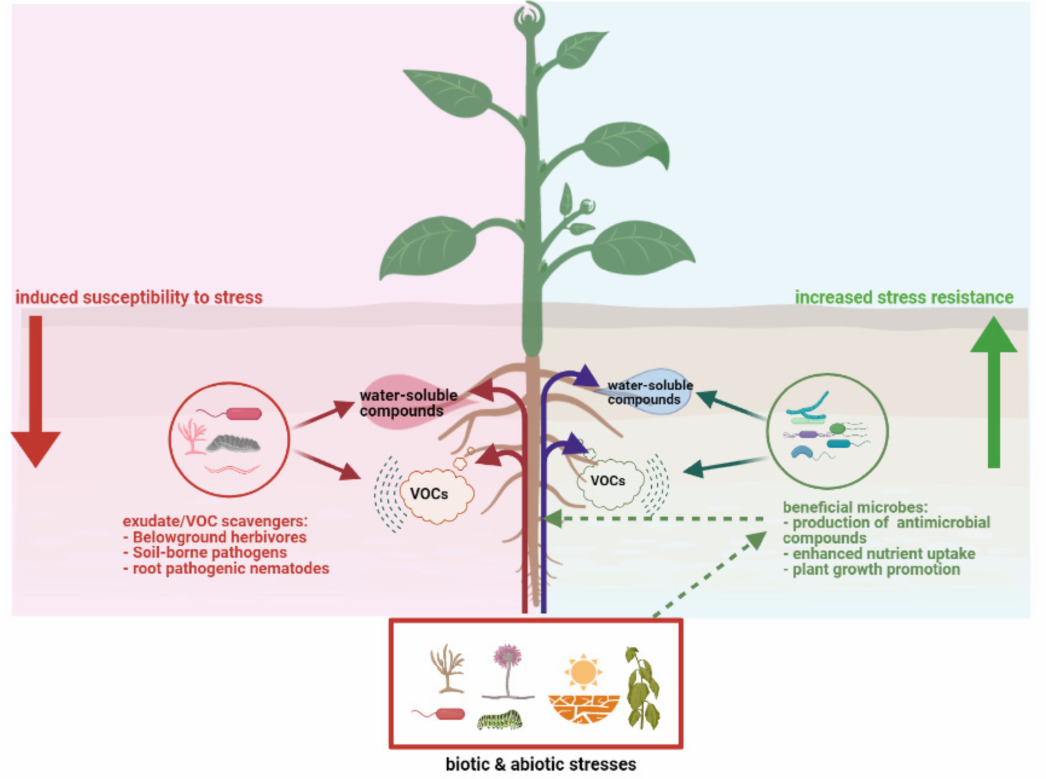
Figure 2. Schematic overview of how plants under siege can attract via exudation of specialized volatile and water-soluble root exudates, beneficial microorganisms which in turn can enhance plant fitness ( right panel ). At the same time, the exudates can also be used by scavengers such as belowground pathogens and pests as chemical information to locate and benefit from the stressed plants, leading to induced susceptibility to stresses ( left panel ). Furthermore, the biotic and abiotic stresses such as drought, salinity, nutrient limitations and pathogens, pests are stress factors not only for the plants but also for the root-associated microbiome (right panel) which can provide early warning and protection to the plant. This figure was designed with Biorender (https://www.biorender.com, accessed on 18 April